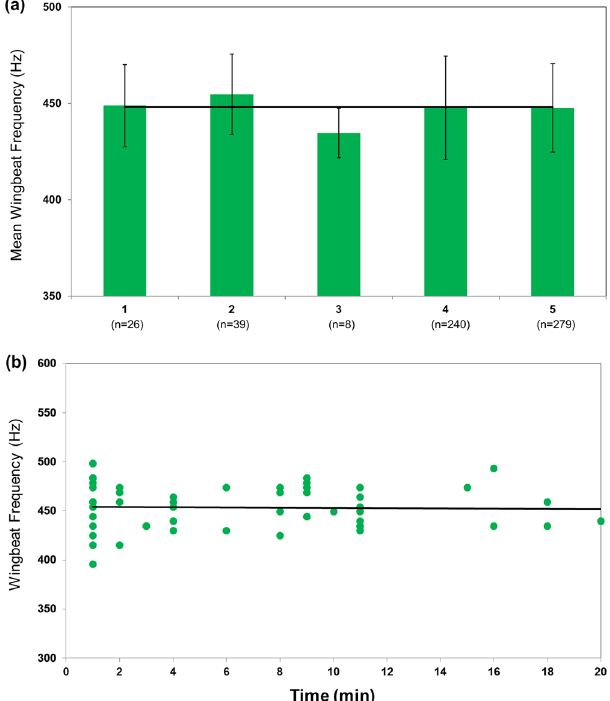
Figure 2. Wingbeat frequencies of Culex quinquefasciatus . ( a ) Mean (± standard deviation) wingbeat frequencies of five individuals. Wingbeat files with fewer than five valid data points were excluded from the analysis. ( b ) Changes in wingbeat frequencies over time. Wingbeat frequency was measured using paired infrared emitters and receivers, capturing wingbeat as a function of infrared light interruption.